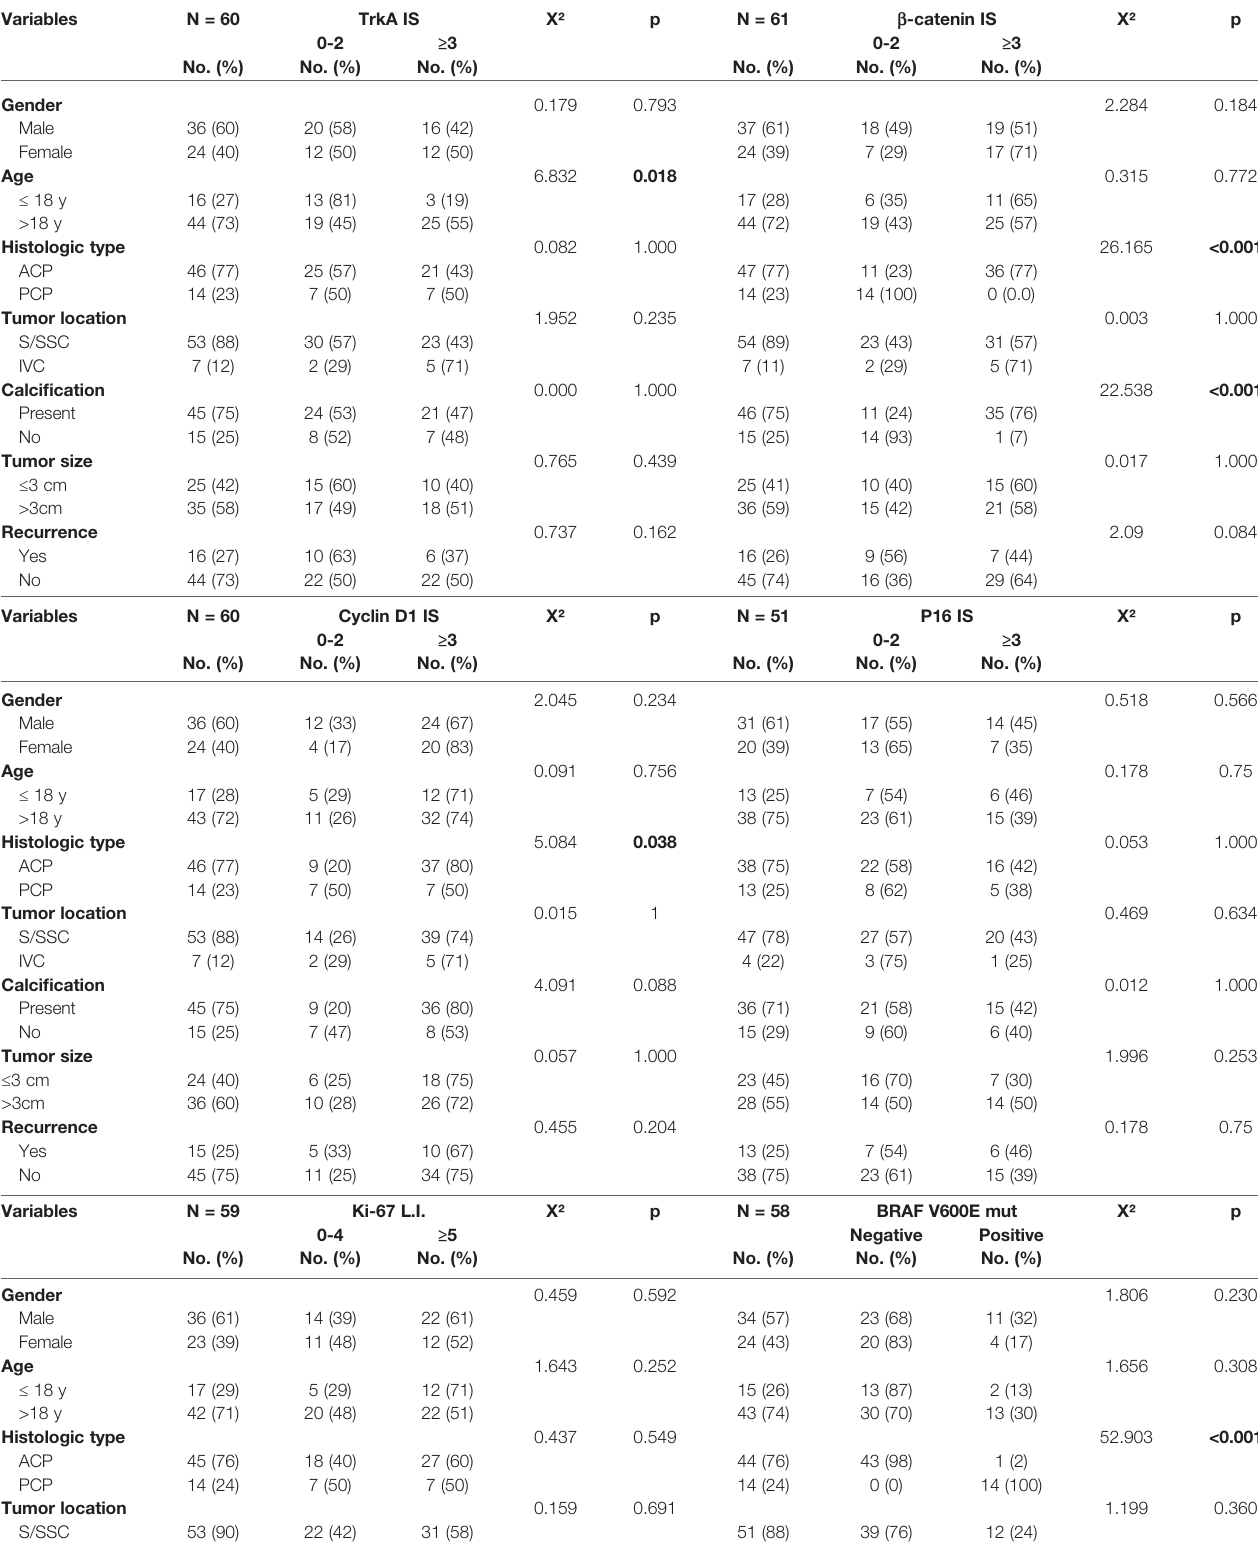
TABLE 3 | The relationship between immunohistochemical scores, BRAF V600E mutation, and clinical features of craniopharyngioma.